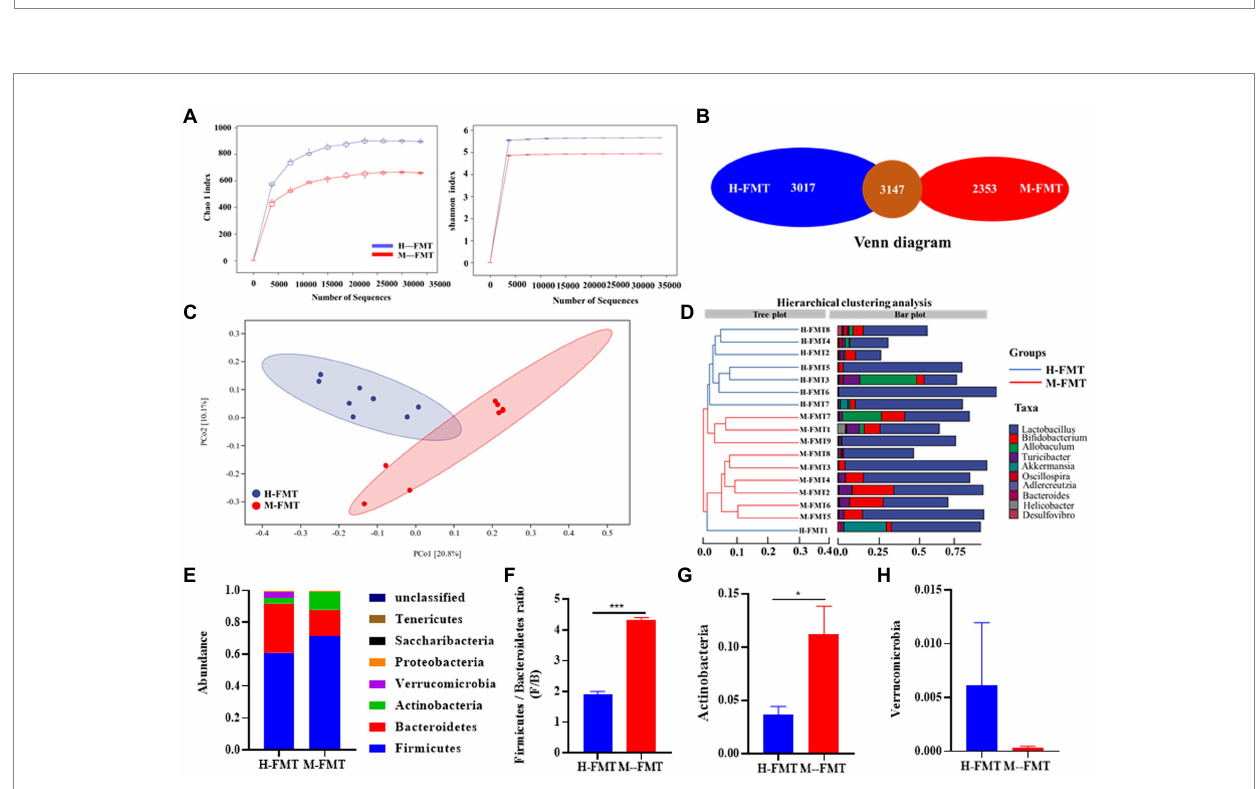
FIGURE 4 The distinction between healthy and lactation mastitis intestinal microbiota in the mice after FMT. (A) Alpha diversity, including Chao 1 and Shannon diversity index. (B) Venn diagram. (C) Unweighted UniFrac distances between healthy and lactation mastitis groups in a PCoA. (D) Hierarchical clustering tree on genus level using the Bray–Curtis distance (left)and the component proportion of bacteria at the genus level in each group (right). (E) Relative abundance of the phyla in the feces. (F) The Firmicutes: bacteroidetes ratio(F/B) was calculated as a biomarker for gut dysbiosis. (G,H) Relative abundances of Actinobacteria and Verrucomicrobia between H-FMT and M-FMT groups. n = 8–10 mice per group. * p < 0.05, *** p < 0.001 by t